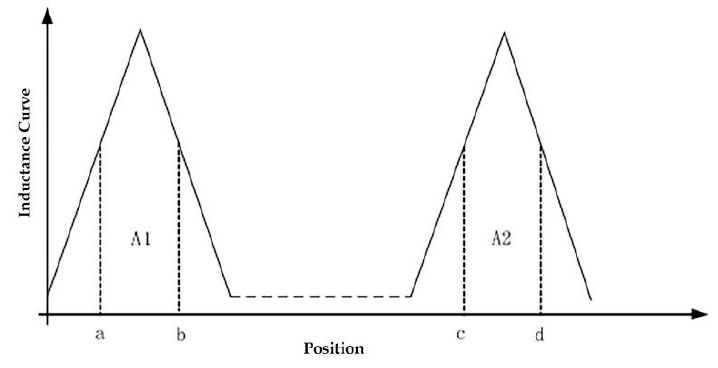
Figure 13. Distribution of penalty coefficient.